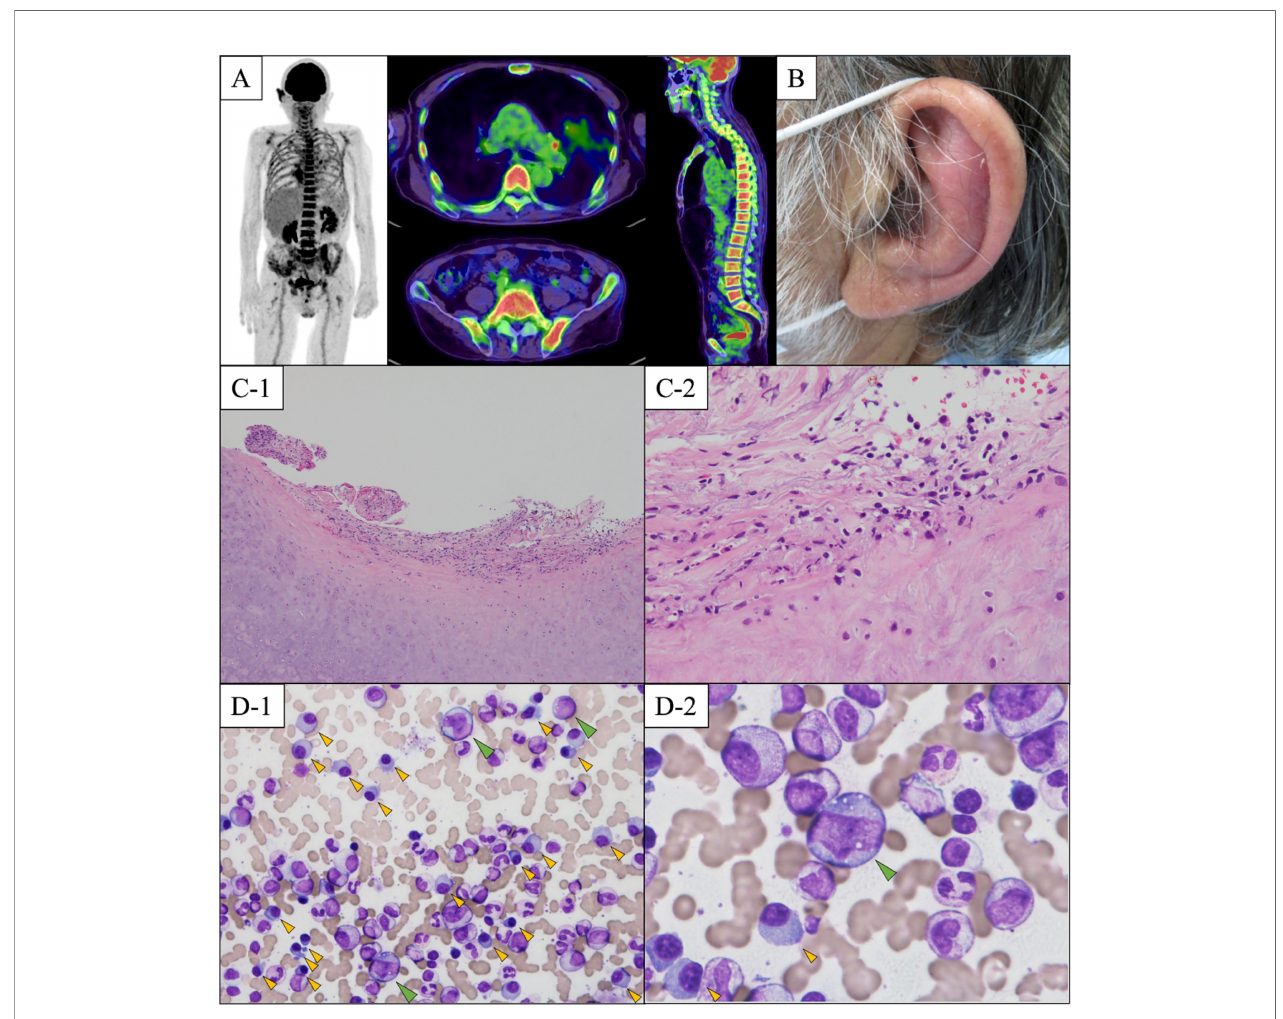
FIGURE 2 | (A) Result of 18 F- fl uorodeoxyglucose (FDG) positron emission tomography-computed tomography. There is marked FDG accumulation in the ribs, vertebrae, and ilium. (B) A fl oppy left ear. Our patient had prominent redness and pain in the left auricular region. (C) Histological fi ndings of a biopsy specimen from the left auricle. In fl ammatory cell in fi ltration of neutrophils around the auricular cartilage is observed (C-1) . In addition, granuloma formation consisting of fi brosis and hypervascularization suggestive of chronic in fl ammation is observed (C-2) (hematoxylin and eosin staining, (C-1) original magni fi cation ×40, (C-2) original magni fi cation ×100). (D) Bone marrow smear fi ndings. (D-1) Clonal expansion of plasma cells is shown by the yellow arrows. The bone marrow dysplasia suggesting MDS is not observed. (D-2) Vacuolization in granulocytic precursor cells are shown by green arrow. (May – Giemsa staining, (D-1) original magni fi cation ×400, (D-2) original magni fi cation